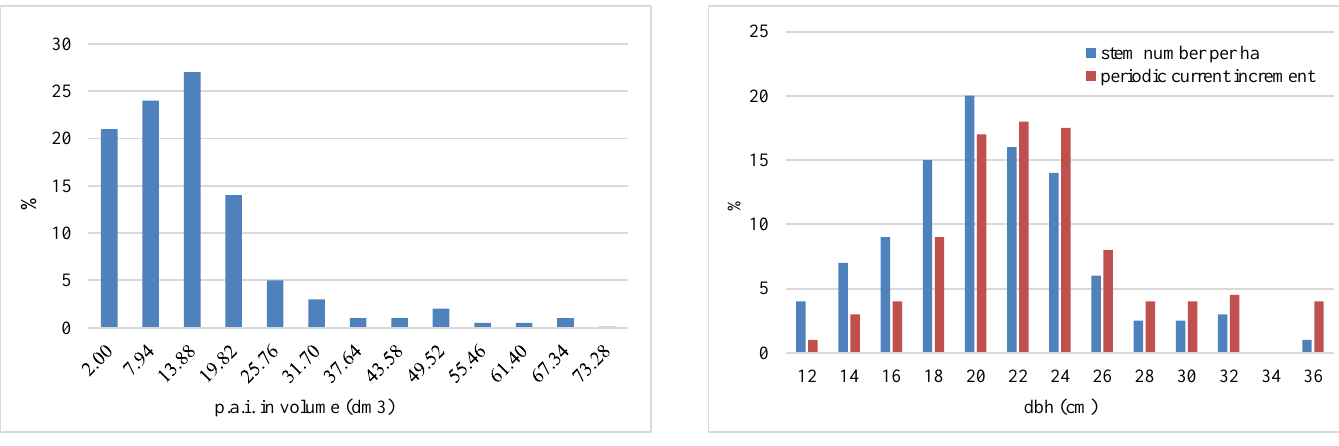
Figure 2. Frequency distribution of periodic annual increment (p.a.i.) in volume (dm 3 ) between 10 and 27 ages (Pusztavacs 215 E)3